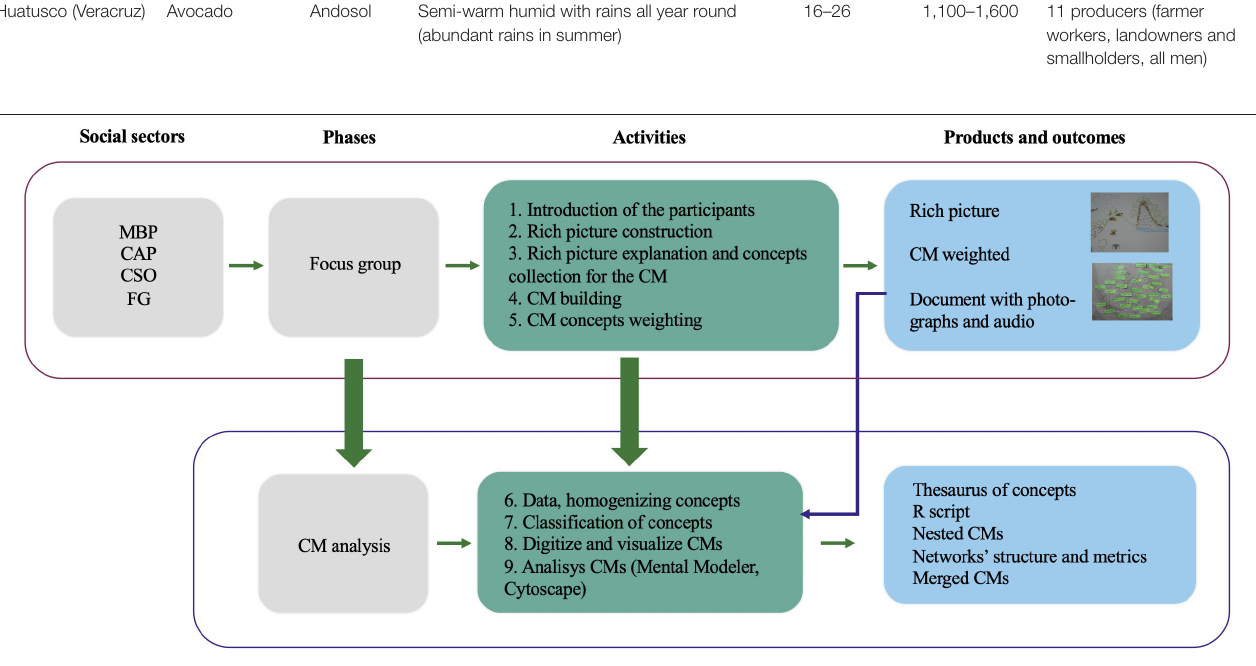
FIGURE 2 | Summary of the workflow and methods involved in the work with focus groups, and in eliciting perceptions and analyzing the